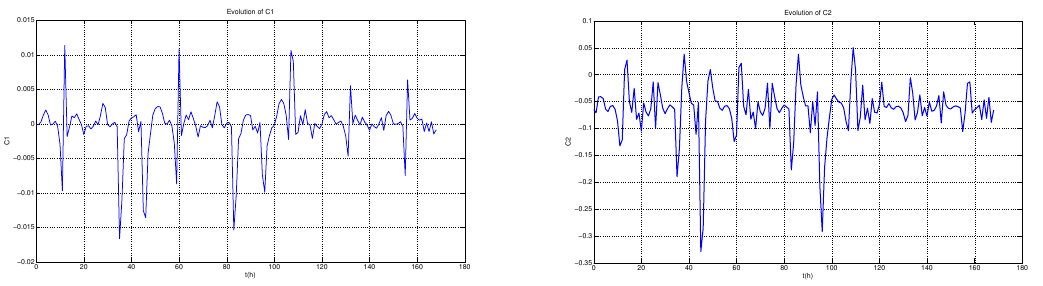
Figure 19. Evolution of the degrees of freedom c 1 and c 2 for the case